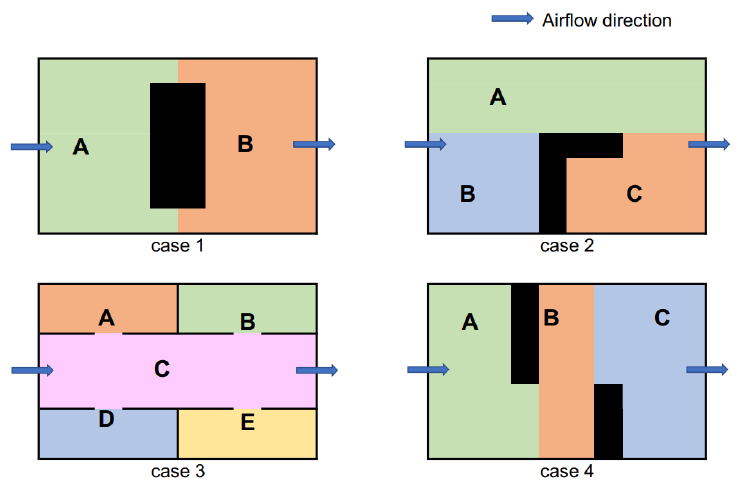
Figure 3. Environments divided into sub-environments (A–E) based on their geometry and air- flow